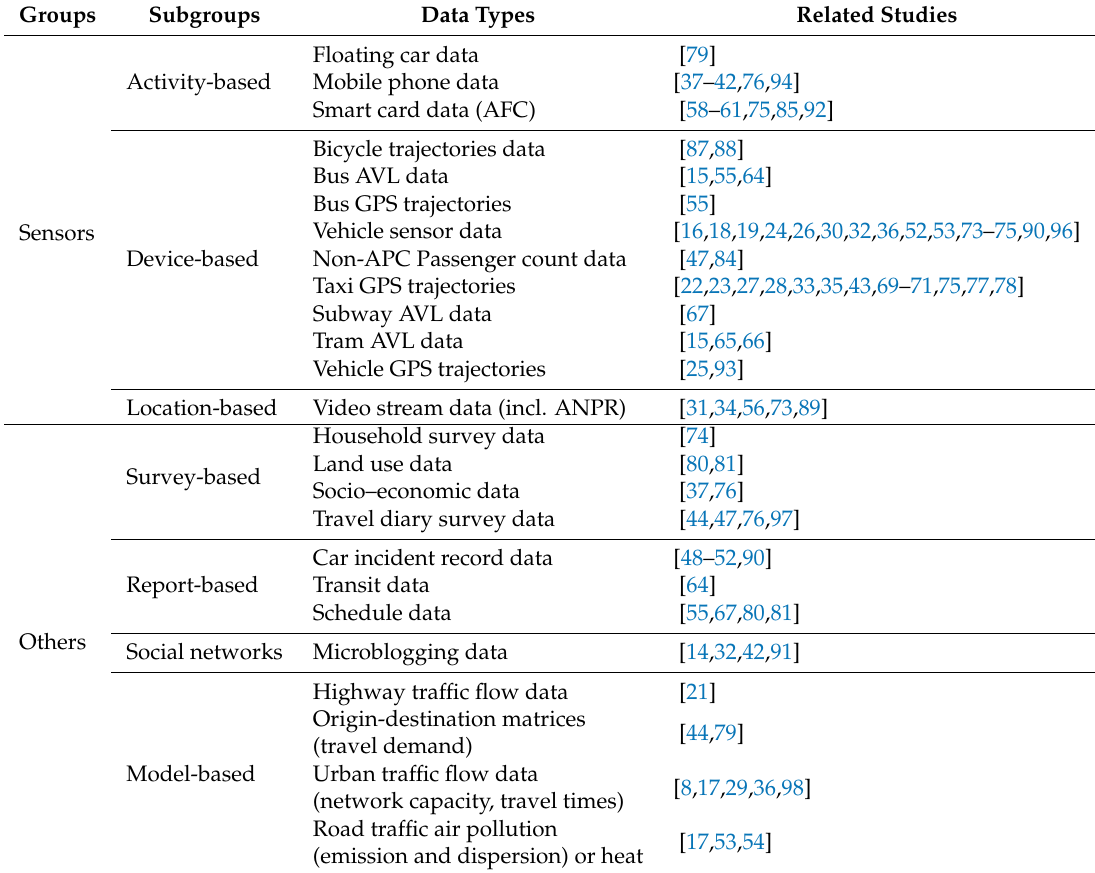
Table 2. Data types found in surveyed studies and their